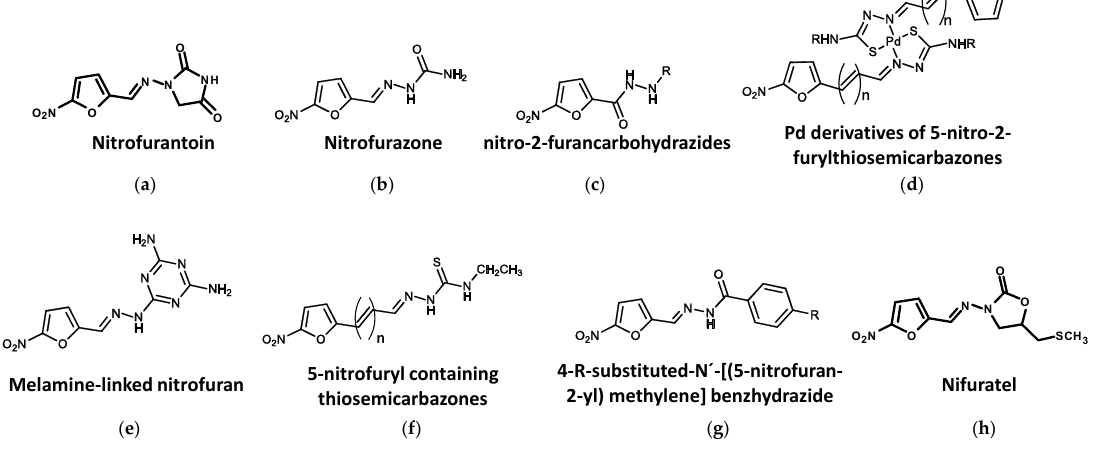
Figure 6. Nitrofuran compounds in di ff erent stages of development against trypanosomatids. ( a ) Nitrofurantoin. ( b ) Nitrofurazone. ( c ) 5-nitro-2-furancarbohydrazides. ( d ) Pd derivatives of 5-nitro-2-furylthiosemicarbazones. ( e ) Melamine-linked nitrofuran. ( f ) 5-nitrofuryl containing thiosemicarbazones. ( g ) 4-R-substituted-N ′ -[(5-nitrofuran-2-yl) methylene] benzhydrazide. ( h ) Nifuratel.